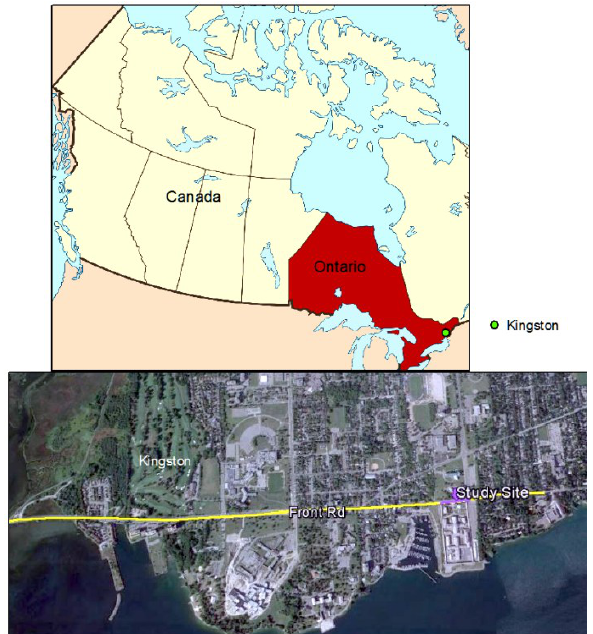
Figure 1. Location of the study area, Kingston, Ontario, Canada PAVEMENT CRACK DETECTION